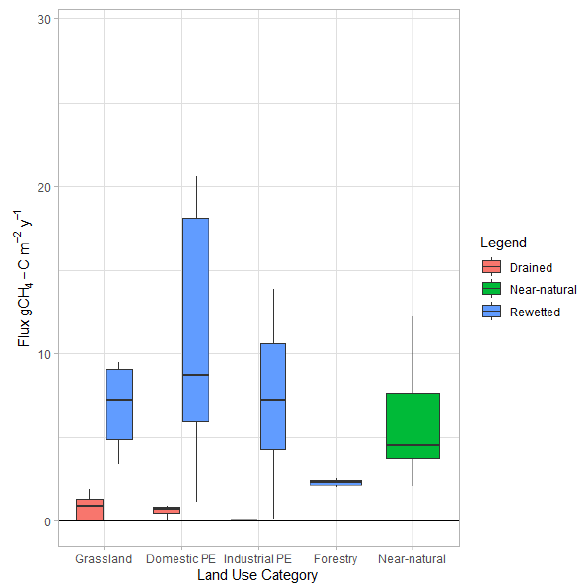
Figure 3. Boxplots of annual carbon dioxide (CO fluxes (g C m - ² y - ¹) from Irish peatlands. Boxplots show median flux (line) with 25 th to 75 th interquartile range as the extent of the coloured box. Error lines denote the range of values. Positive values indicate emissions from the soil and negative values indicate removal from the atmosphere. PE = Peat Extraction.